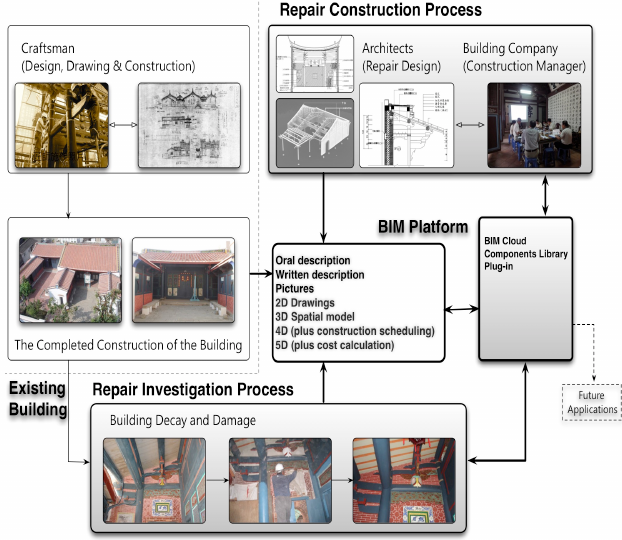
Figure 2. BIM creation workflow for Historic Building Repair Construction